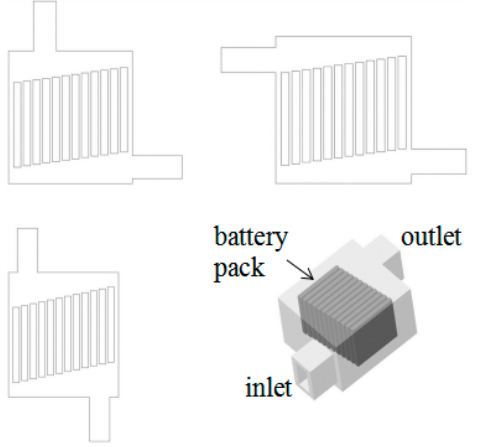
Figure 19. A representative air-cooling system. Adopted from Ref. [243].